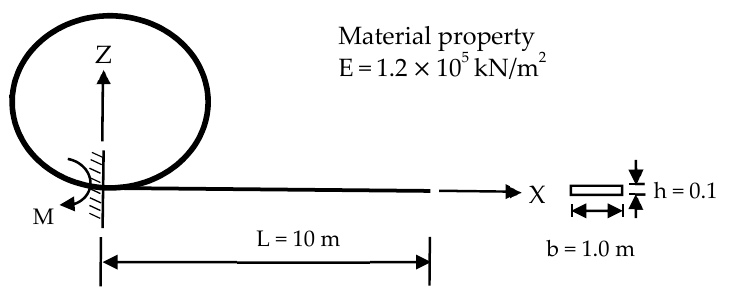
Figure 4. Cantilever curved beam of a circle subjected to an end moment.